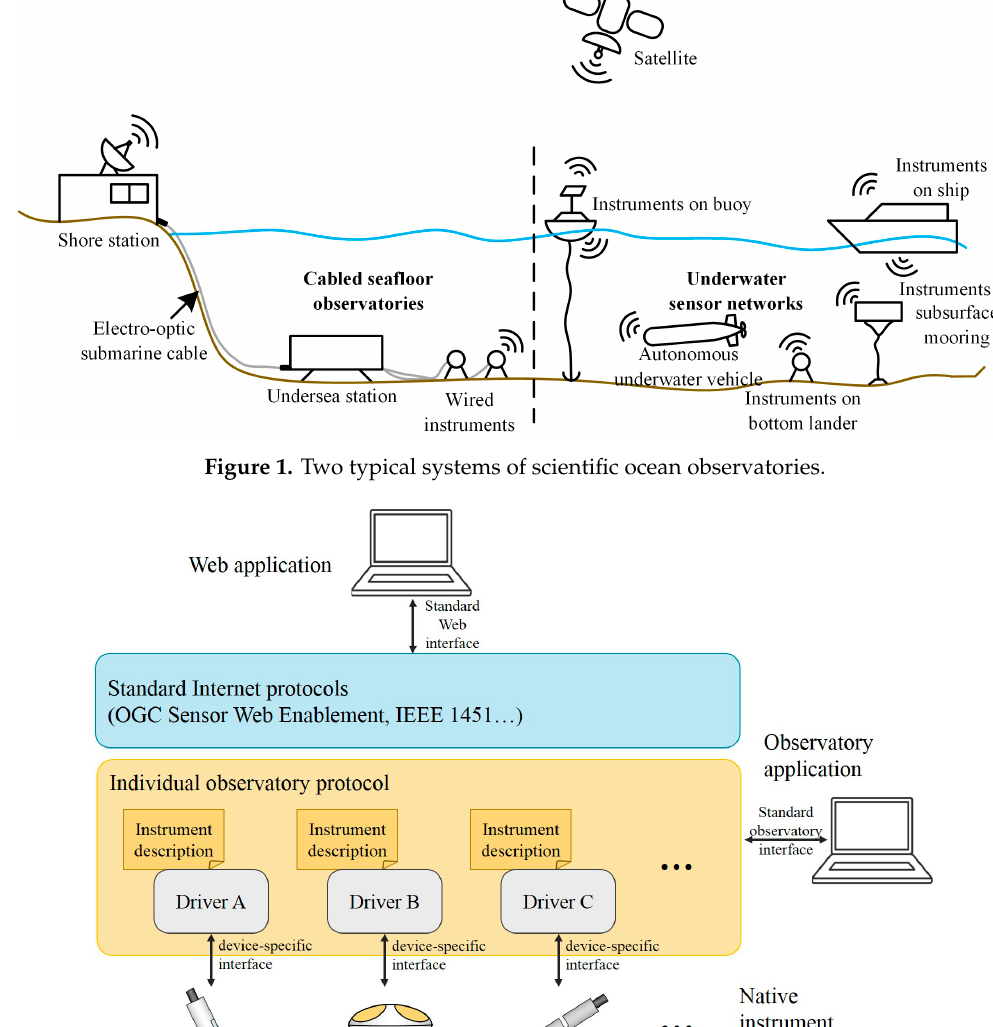
Figure 1. Two typical systems of scientific ocean